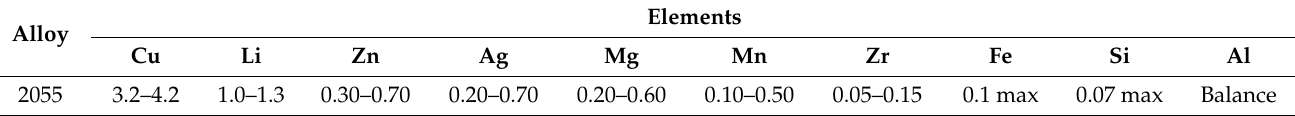
Table 1. The nominal chemical composition of AA2055 alloy